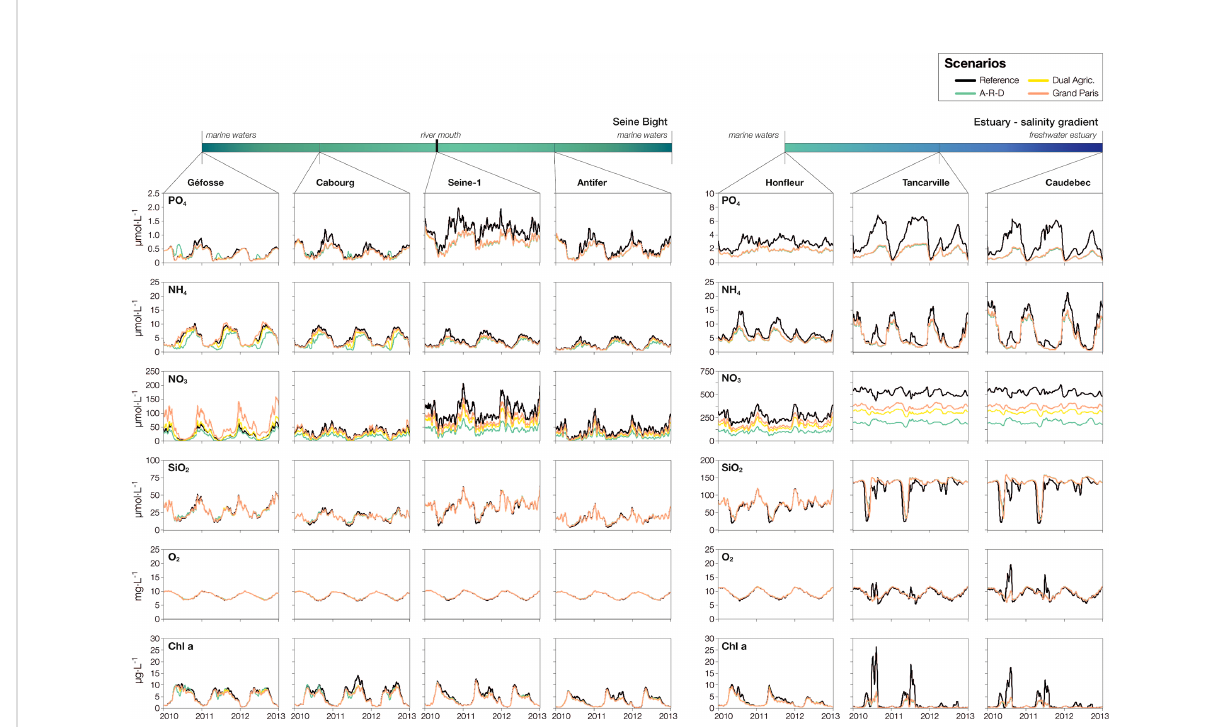
FIGURE 5 Nutrients, dissolved oxygen and chlorophyll concentration in three estuarine stations (upstream to downstream: Caudebec, Tancarville, Hon fl eur) and four marine stations (Ge ́ fosse, Cabourg, Seine1, Antifer). The location of the stations is shown in Figure 1. The period matches the one in Figure 4 (2010-2013) to allow comparisons between the riverine, estuarine and marine